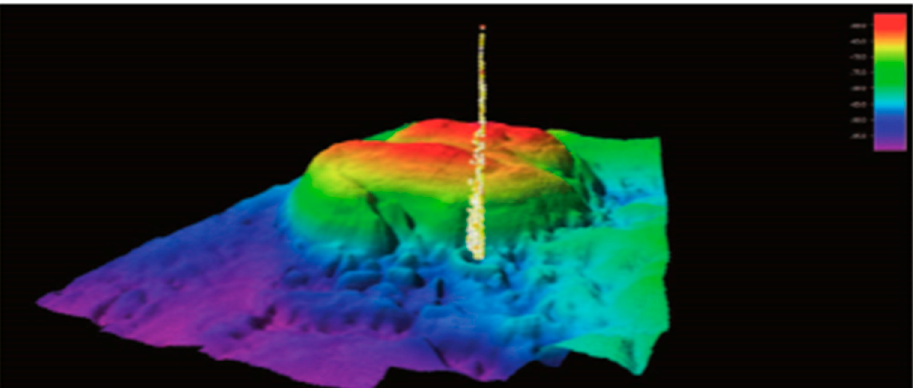
Figure 13. A 3D image of a gas plume and a pingo, Universitetskaya structure, Kara Sea shelf (number on the map: 29) [74].